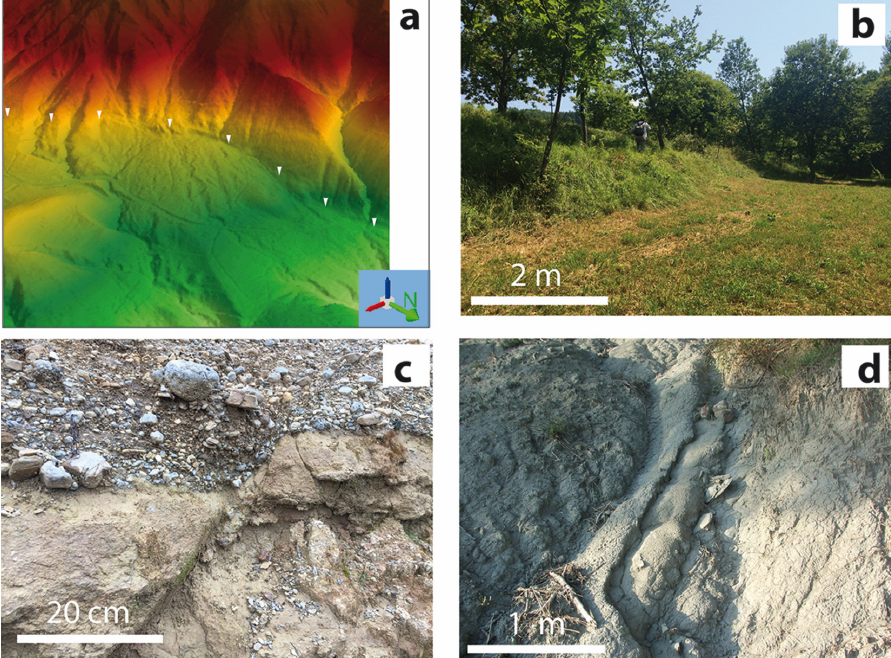
Figure 4. Evidence of Plio-Quaternary faulting and deformation: ( a ) LiDAR-derived DTM showing the fault scarp offsetting a Late Pleistocene–Holocene alluvial fan along the Mulazzo Fault in the structural domain SD2 (Lunigiana). This site has been recently trenched for paleoseismological studies [68,69]; ( b ) fault scarp offsetting Late Pleistocene alluvial fan deposit along the southernmost splay of the Corfino Fault, in structural domain SD3 (Garfagnana); ( c ) normal fault offsetting the Late Villafranchian Olivola Conglomerates, in structural domain SD2 (Lunigiana); ( d ) Ruscinian Sarzanello–Caniparola sands and clay tilted by the Sarzana–Carrara fault, in the northern part of the West Alpi Apuane Fault system in the structural domain SD6 (La Spezia–lower Lunigiana). Locations of these sites are shown in the Figures related to the different SDs.